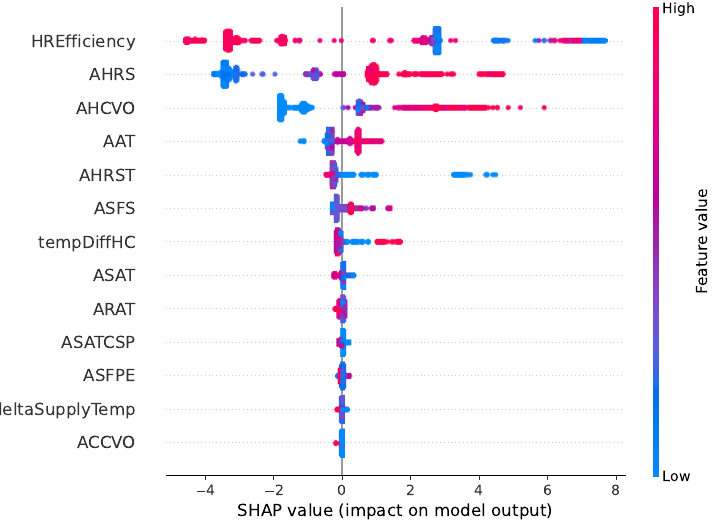
Figure 8. Summary of the effects of all the features on the XGBoost model prediction of the fault type “Heat recovery not working”.